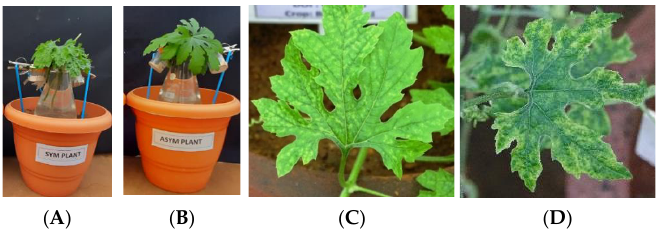
Figure 6. Whitefly transmission of ToLCNDV from microplot grow-out test plants. ( A ) Whiteflies feeding on symptomatic leaves −24 h (AAP); ( B ) Whiteflies feeding on Asymptomatic leaves −24 h (AAP); ( C ) Symptom expressed in plants transmitted from symptomatic plants ( D ) Symptom expressed in plants transmitted from asymptomatic plants.